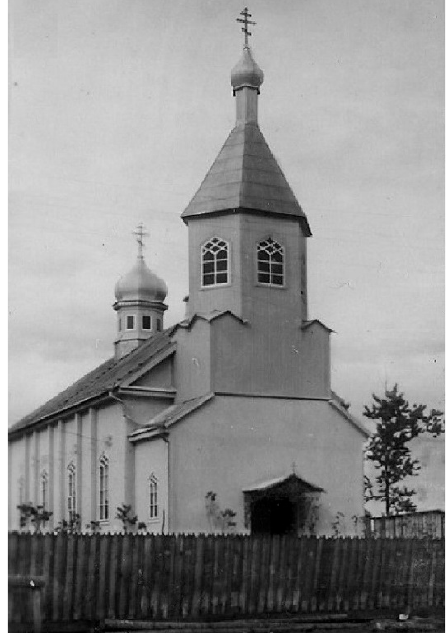
Figure 2. Edinoverie Church of St Andrew (source: Kaunas Public Library).